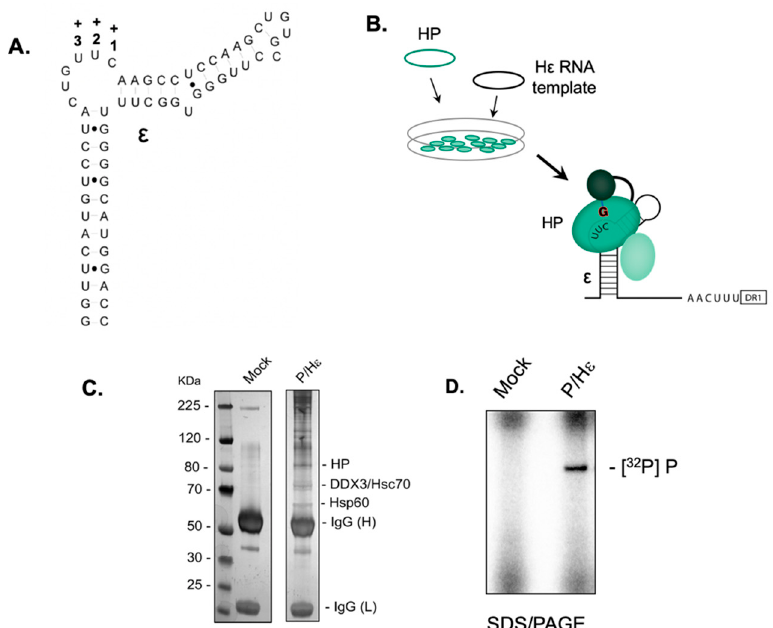
Figure1. Establishingthein vitroHBVPproteinprimingsystem. ( A )StructureofHBV ε RNA,outlining Figure 1. Establishing the in vitro HBV P protein priming system. ( A ) Structure of HBV ε RNA, the priming loop and the site at which minus-strand DNA is initiated ( + 1, + 2, + 3 ). ( B ) Experimental outlining the priming loop and the site at which minus-strand DNA is initiated ( +1, +2, +3 ). ( B ) HBV minus-strand priming strategy. HEK293T cells are transfected with plasmid pCMV-3FHP (protein Experimental HBV minus-strand priming strategy. HEK293T cells are transfected with plasmid components, green), or in combination with plasmid pCMV-H ε (RNA component, black), and a clarified pCMV-3FHP (protein components, green), or in combination with plasmid pCMV-H ε (RNA homogenate is immobilized on anti-FLAG beads. ( C ) Identification of cellular factors of the initiation component, black), and a clarified homogenate is immobilized on anti-FLAG beads. ( C ) Identification complex. The lane designated “Mock” represents an immobilized homogenate of non-transfected of cellular factors of the initiation complex. The lane designated “Mock” represents an immobilized cells. Migration positions of cellular factors are taken from Jones et al. [19], HP, HBV polymerase. homogenate of non-transfected cells. Migration positions of cellular factors are taken from Jones et al. ( D ) P protein-primed, ε -dependent initiation of HBV minus-strand DNA synthesis, reflected by HBV [19], HP, HBV polymerase. ( D ) P protein-primed, ε -dependent initiation of HBV minus-strand DNA polymerase (P) as the sole [ 32 P]-labeled protein of the priming synthesis, reflected by HBV polymerase (P) as the sole [ 32 P]-labeled protein of the priming mixture.